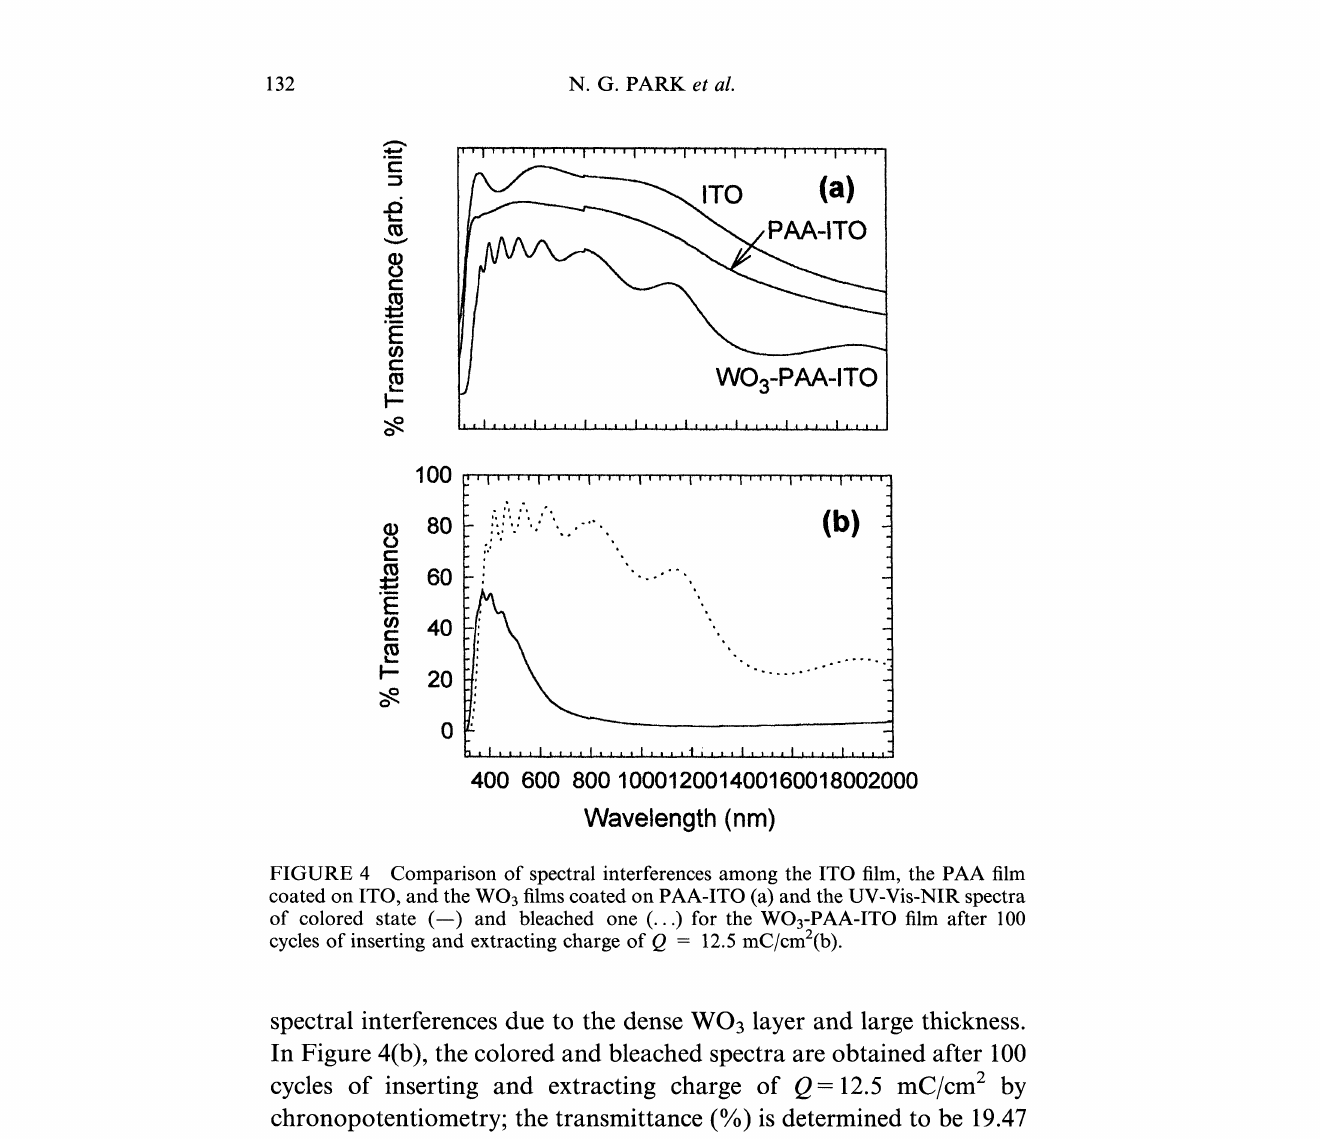
FIGURE 4 Comparison of spectral interferences among the ITO film, the PAA film coated on ITO, and the WO3 films coated on PAA-ITO (a) and the UV-Vis-NIR spectra of colored state (--) and bleached one (...) for the WO3-PAA-ITO film after 100 cycles of inserting and extracting charge of Q 12.5